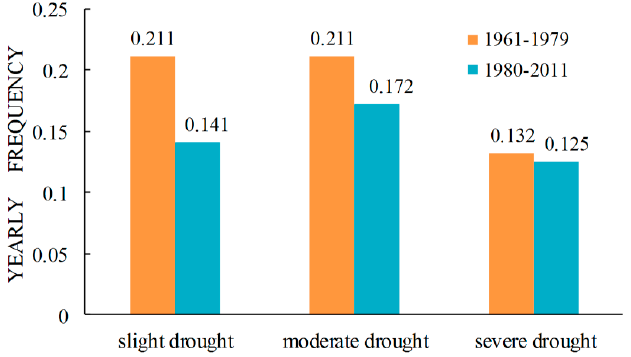
Figure 5. Yearly drought frequency of different categories in the Huang ‐ Huai ‐ Hai River Basin.